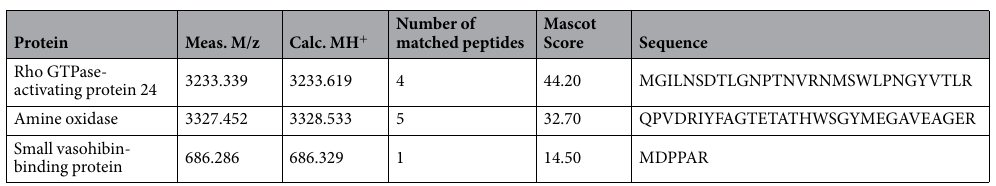
Table 4. The identification of the potential markers used for the estimation of PMI in human liver